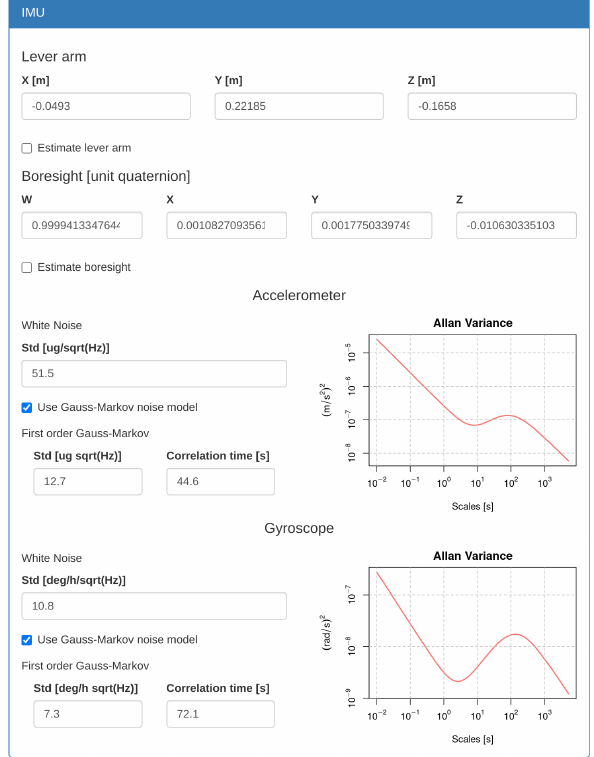
Figure 3. IMU configuration